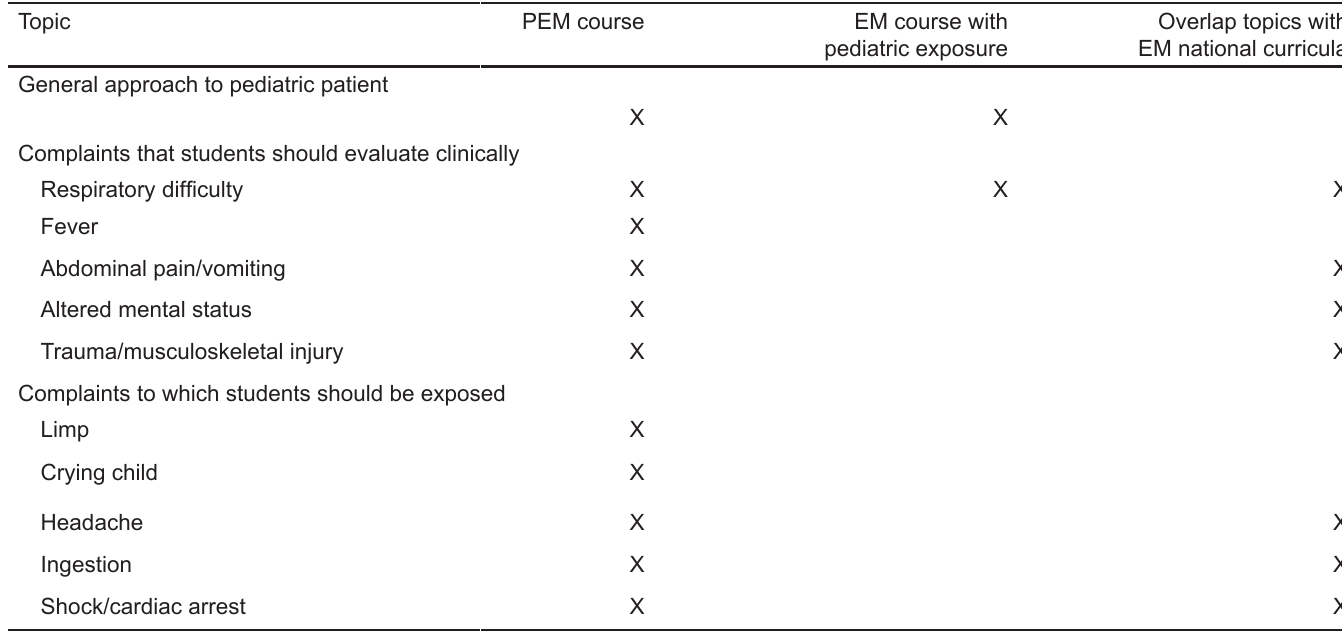
Table 1. Pediatric emergency medicine (PEM) topics/complaints to be covered in PEM/EM clerkships.